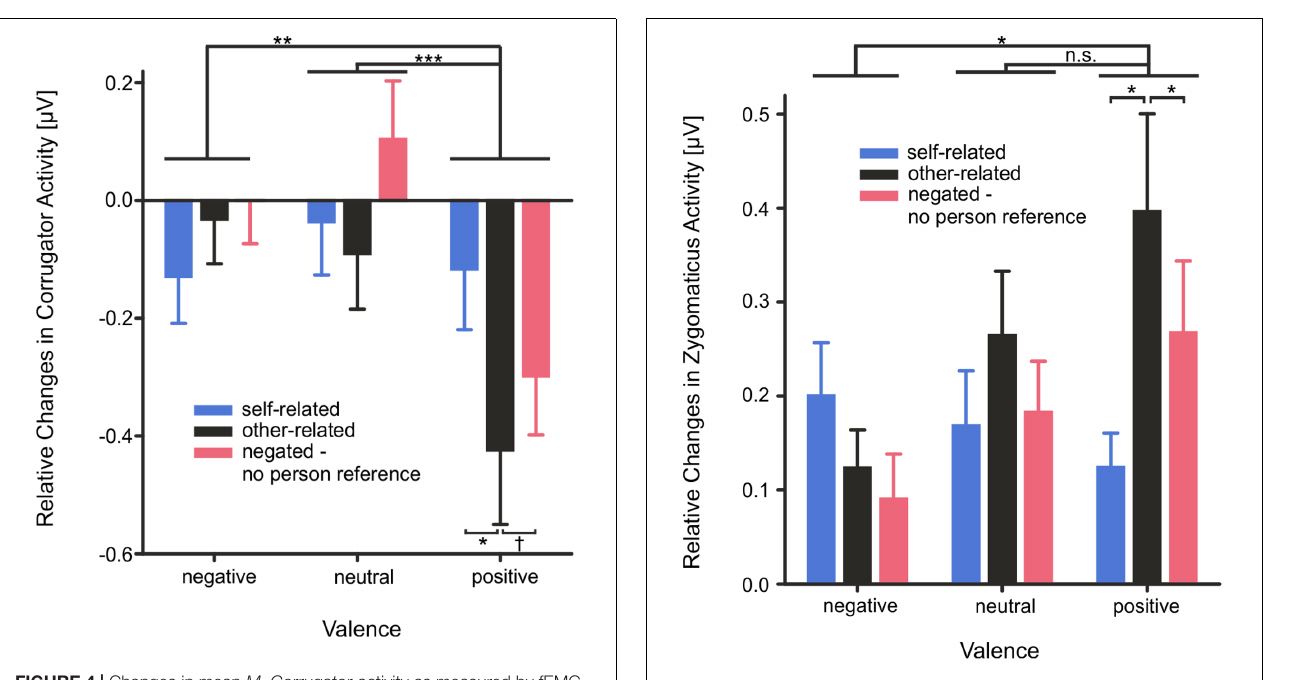
FIGURE 5 | Changes in mean M. Zygomaticus activity as measured by fEMG depicted as mean activity during the stimulus interval from 0 to 4000 ms. Error bars depict SEM. Changes are illustrated as relative changes from baseline. n.s. p > 0.1, ∗ p < 0.05, FDR